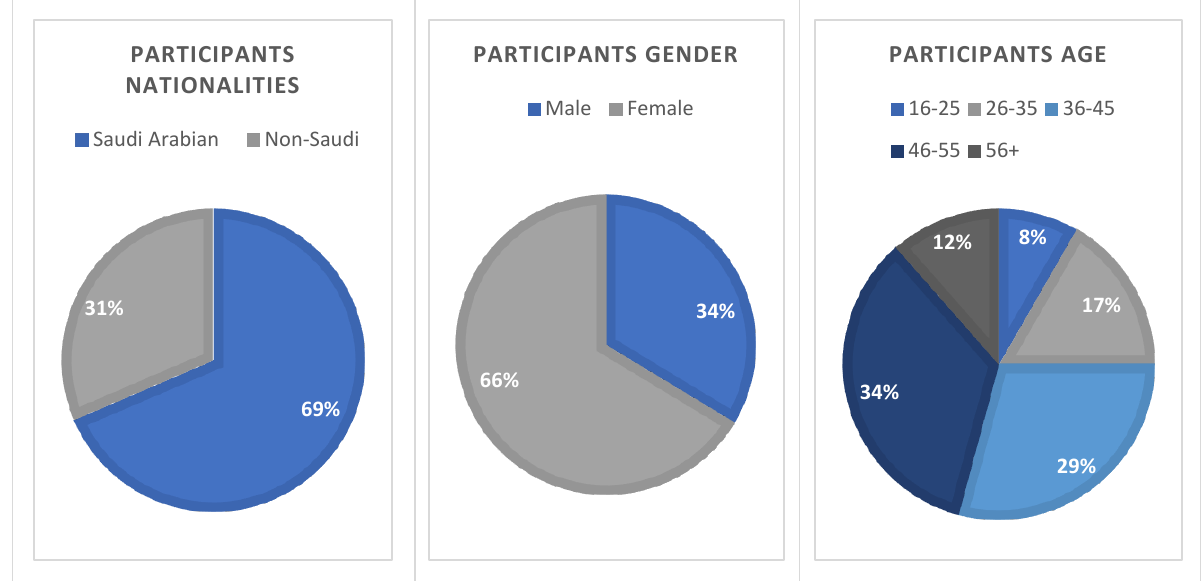
Figure 2. Sampling size and demographic.